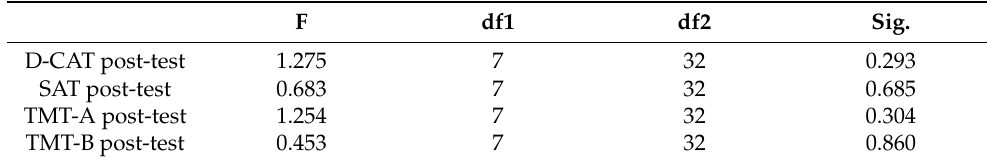
Table 24. Levene’s test of equality of error variances.